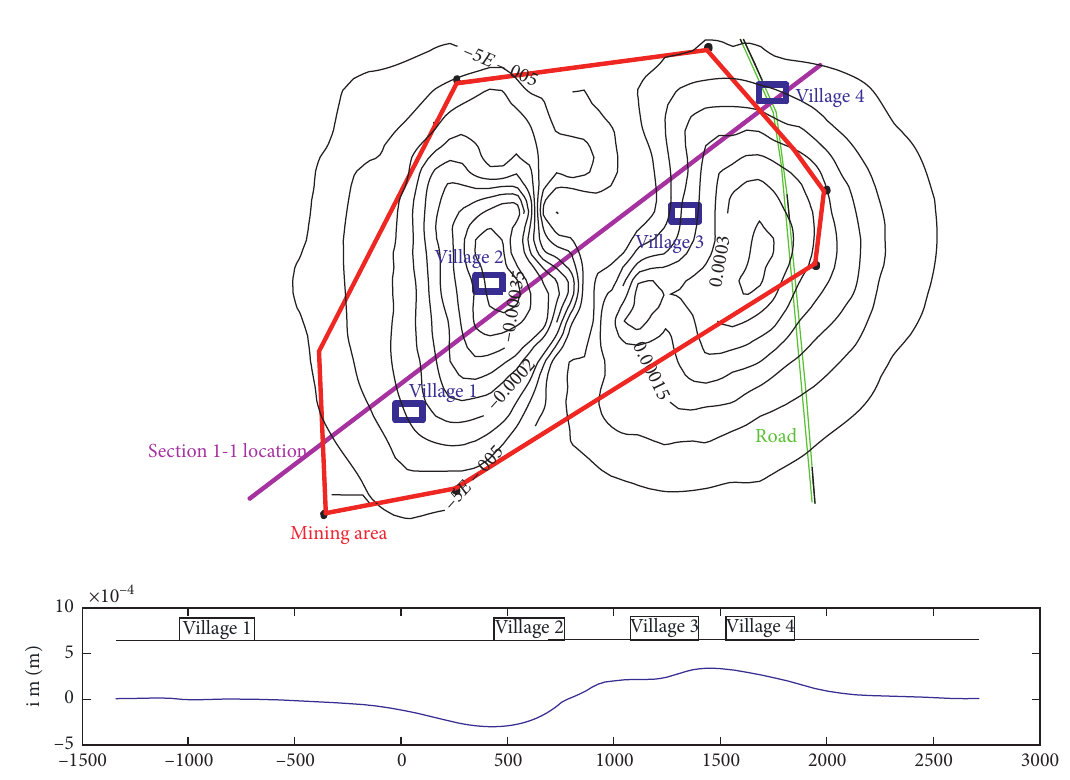
Figure 15: Contour map of surface